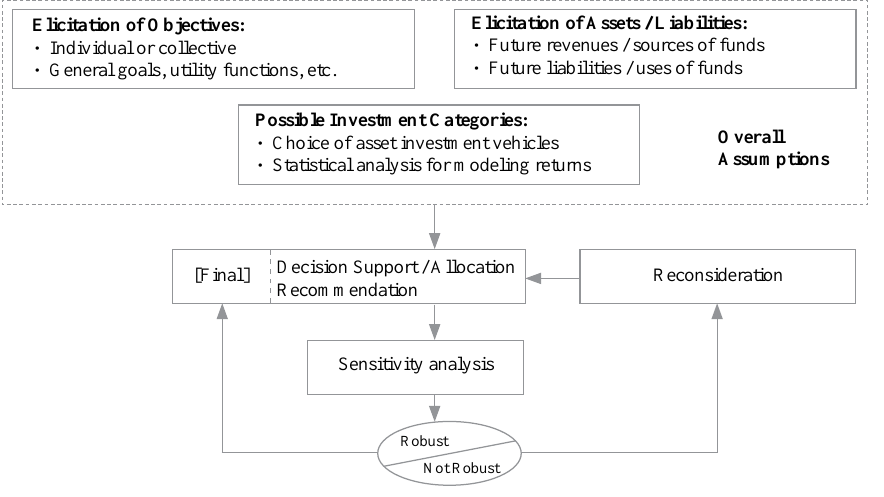
Fig. 1. Decision-making framework for asset liability